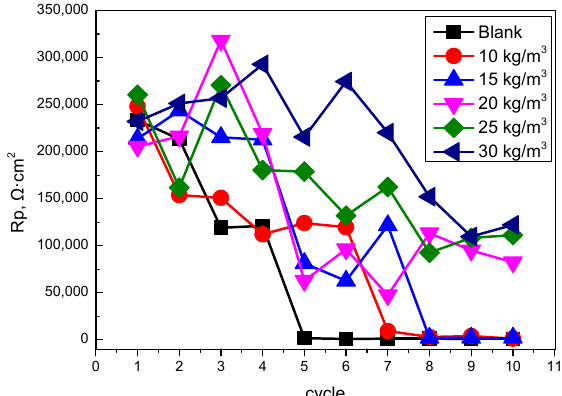
Figure 6. Corrosion resistance of reinforced steel in concrete with different nano-hydrophobic admixtures during the wet–dry cycle.